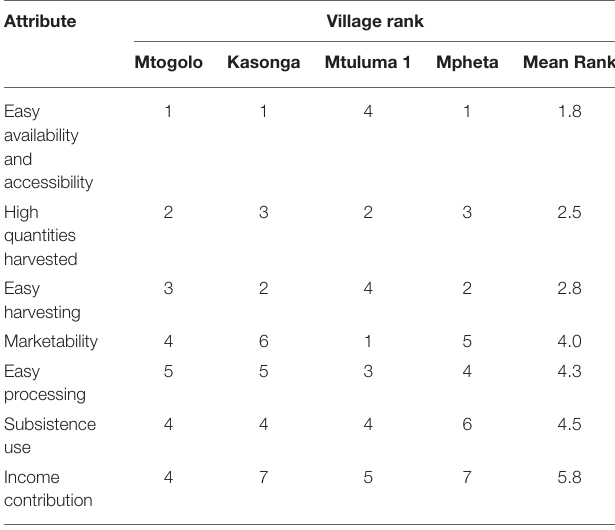
TABLE 10 | Attributes which influence a household’s decision on type of NTFP to sell (ranking 1 = high; 7 = low).